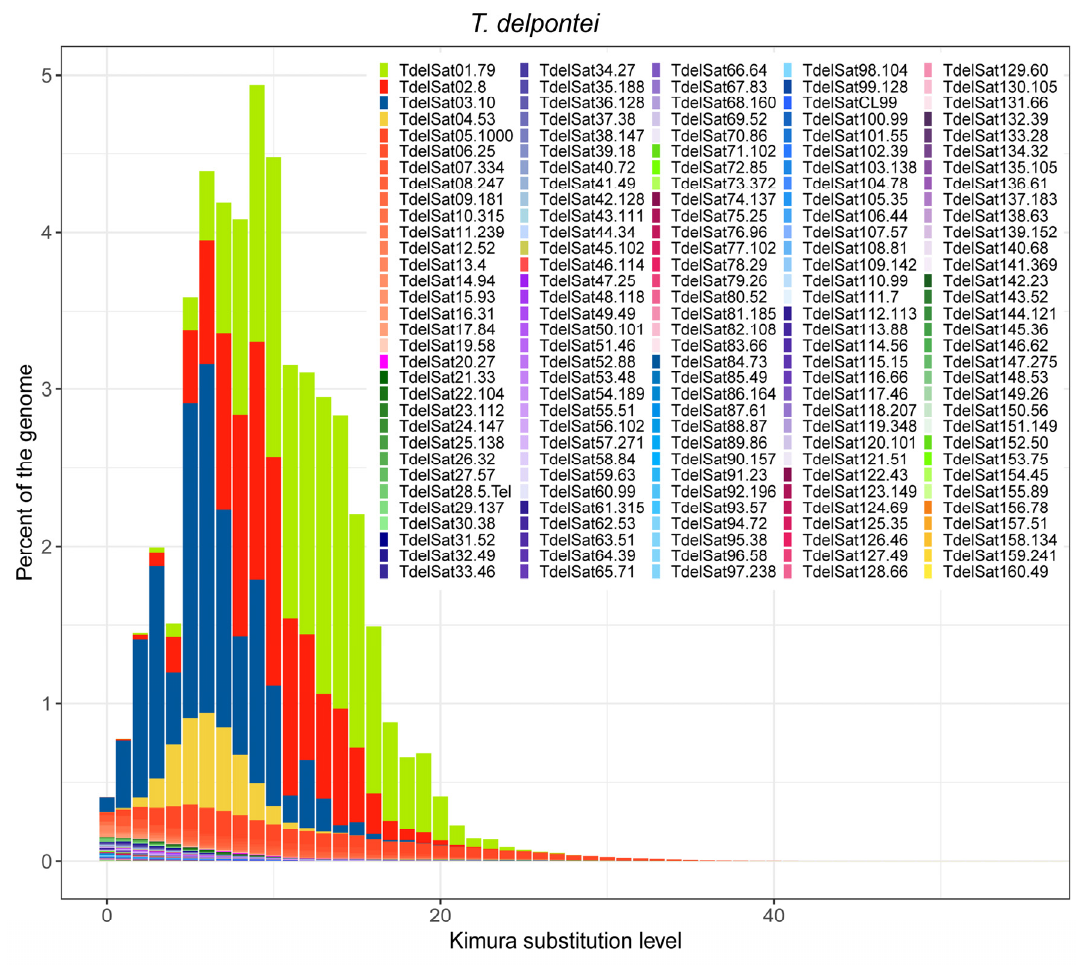
Figure 2. T. delpontei satellite DNA landscape.